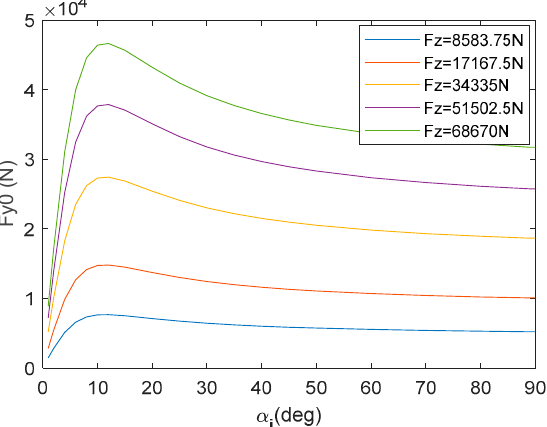
Figure 2. Lateral tire force map in relation to the tire slip angle and vertical tire forces.